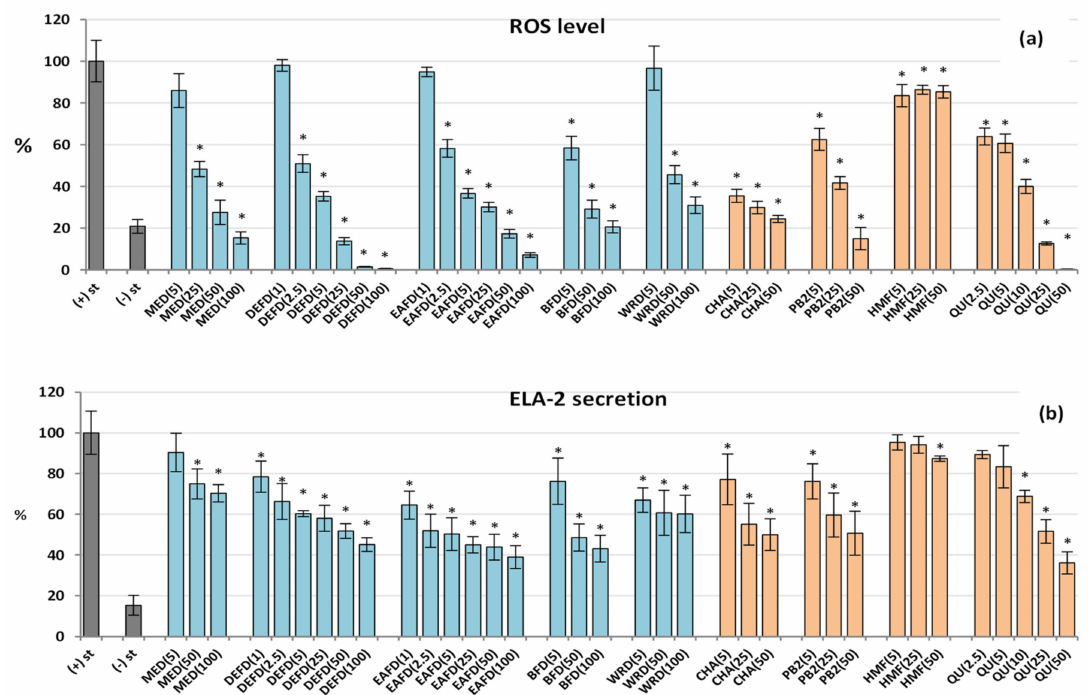
Figure 4. Effect of fruit extracts/fractions (1–100 µ g/mL) and standards (2.5–50 µ M) on the release of ( a ) ROS, reactive oxygen species; ( b ) ELA-2, neutrophils elastase from human neutrophils. Pure